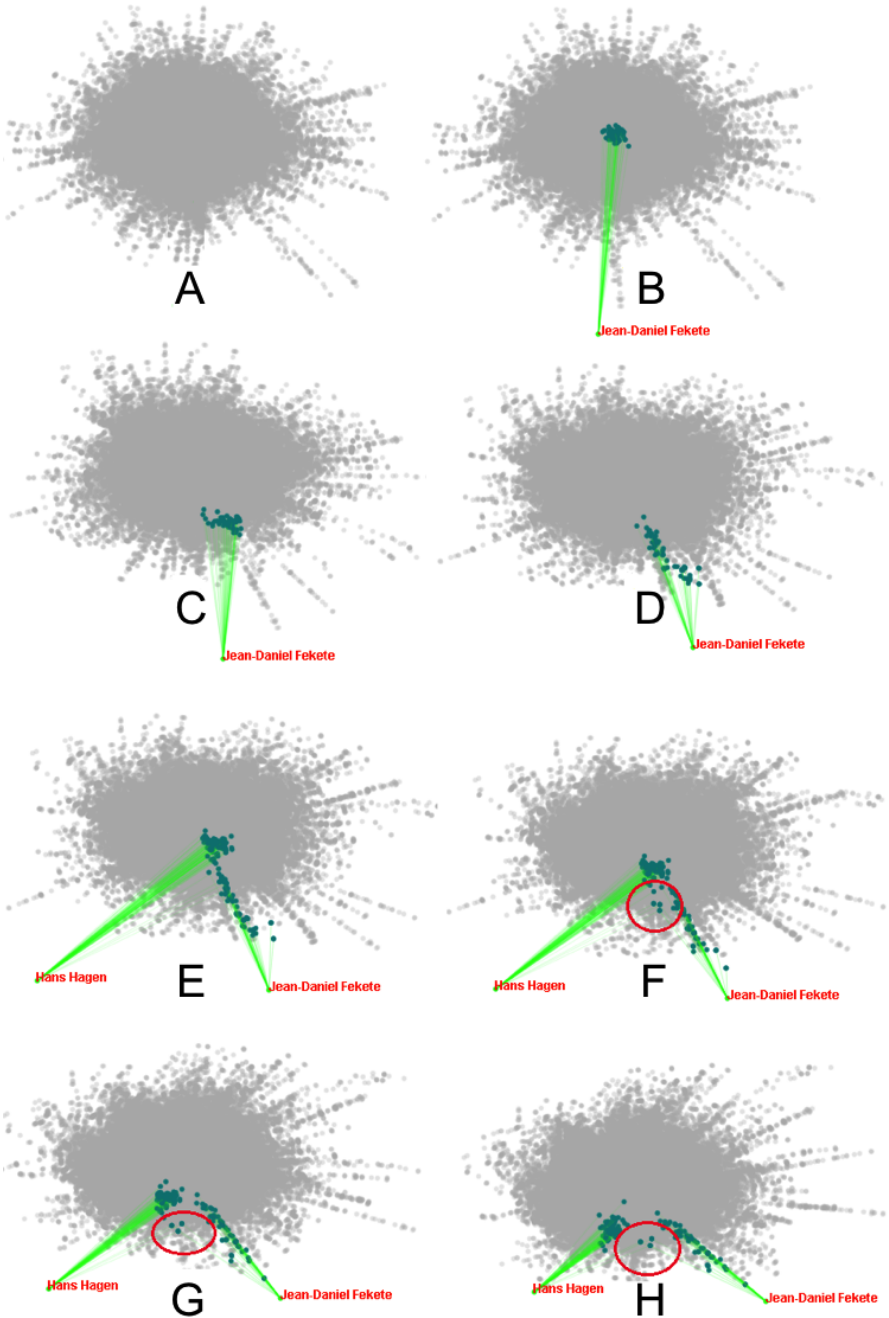
Figure 11. The graph layout of the DBLP co-authorship network, showing a series of interactions. ( A ) shows the initial graph layout using the FM 3 algorithm. The remaining figures show the very similar, but interactive, layout using our algorithm. In ( B ), Jean-Daniel Fekete is dragged away from the network center (the user selected community is automatically highlighted in green). ( C, D ) are snapshots of the resulting dynamic layout movement. In ( E ), Hans Hagen is dragged away from the network center. ( F, G, H ) show resulting node